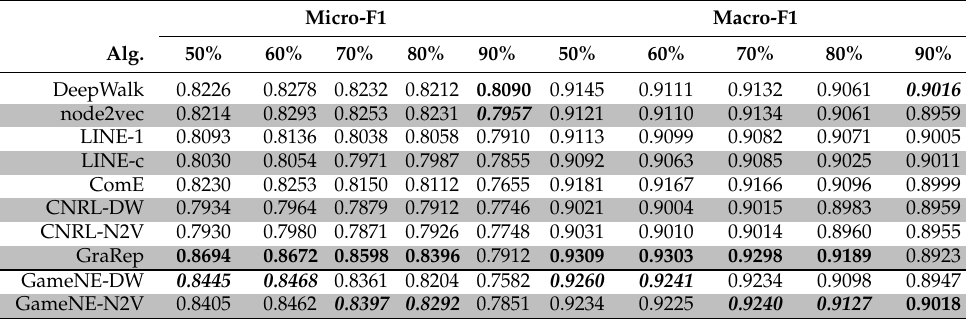
Table 6. Micro- and Macro F1-Scores of Multi-Label Classification, Network on =